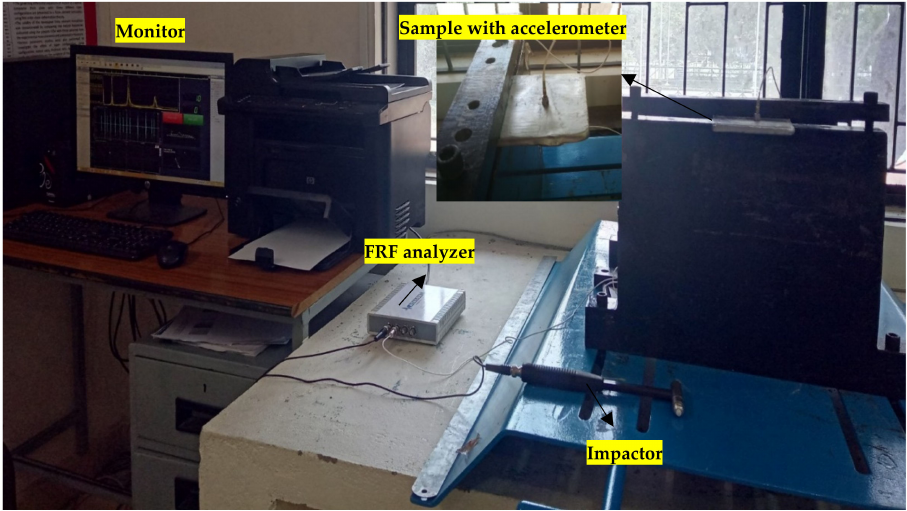
Figure 11. Vibration experimental setup with shock wave surface-treated